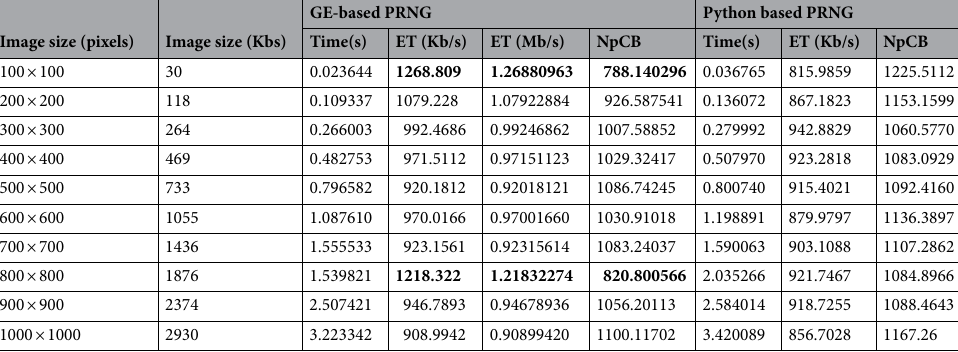
Table 3. Speed analysis of GE based PRNG and Python based PRNG with encryption of RGB